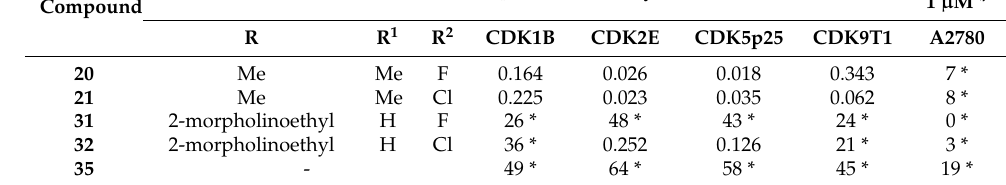
Molecules 2023 , 28 , x FOR PEER REVIEW